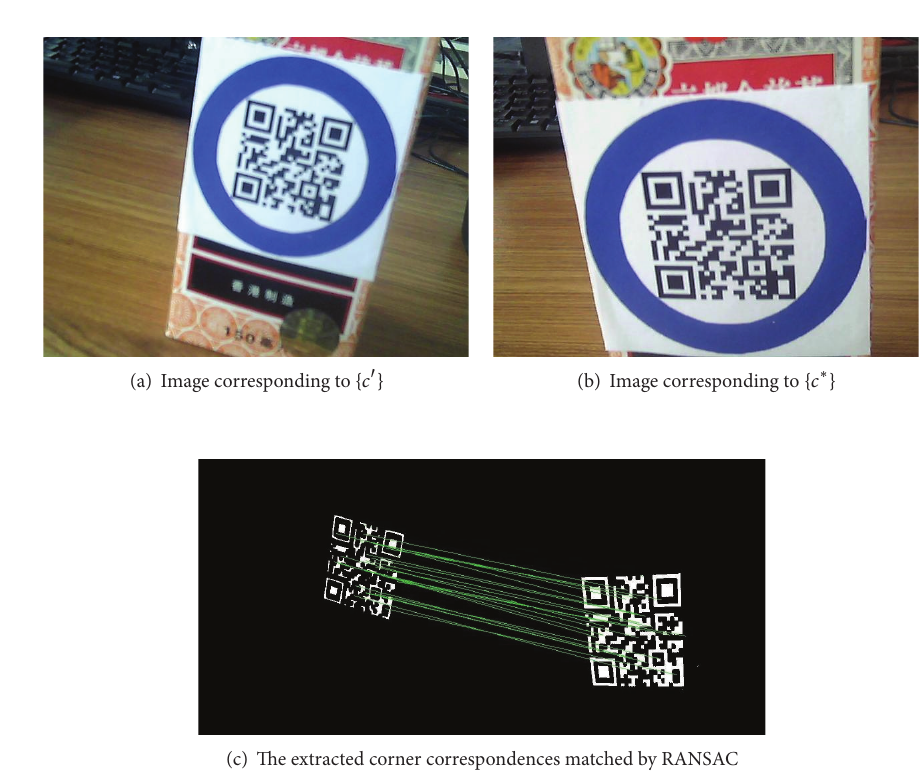
Figure 10: Two images of the object mark corresponding to {𝑐 󸀠 } and {𝑐 ∗ } , together with the extracted corner